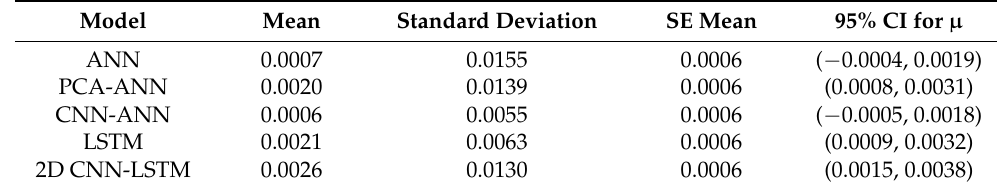
Table 11. Descriptive Statistics of Daily Brent Crude Oil Return’s with